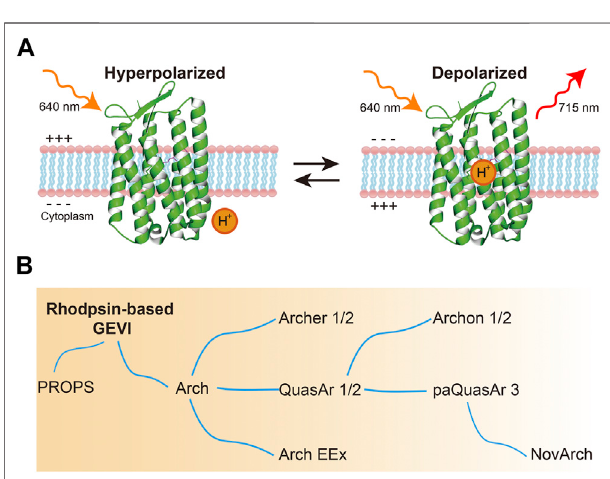
FIGURE 2 | Microbial rhodopsin-based GEVIs. (A) Voltage sensing mechanism of microbial rhodopsin-based GEVIs. Rhodopsin-based GEVIs report voltage changes through the fl uorescence intensity changes of retinal chromophore caused by protonation of the Schiff base in the photointermediate state, not in the ground state. (B) Evolution of microbial rhodopsin-based GEVIs.